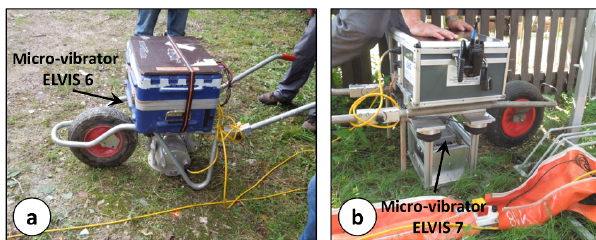
Figure 6. Field campaign in July 2014 using two basically compara- ble seismic sources. (a) Micro-vibrator ELVIS 6 on paved ground, (b) micro-vibrator ELVIS 7 on unpaved ground and landstreamer beside it. The vibrators are ideally suited for application in densely built-up areas such as the medieval city center of Bad Franken-